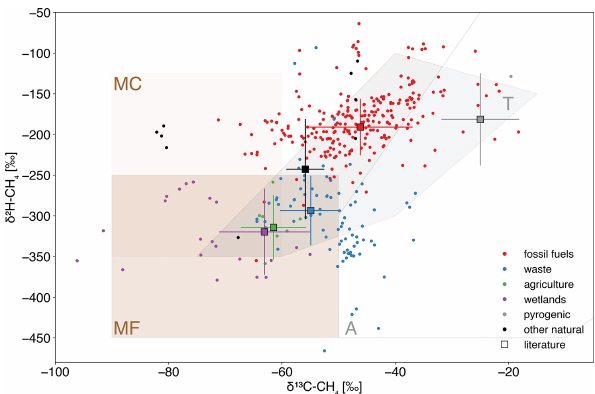
Figure 2. Dual isotope plot presenting measurement results from the EMID (circles); the literature data for the same source cate- gories, taken from Sherwood et al. (2017, 2021), and completed with the mean and standard deviation values from additional publi- cations (squares with error bars); shaded areas represent the differ- ent methanogenesis pathways from Milkov and Etiope (2018): MF: microbial fermentation, MC: microbial CO 2 reduction, T: thermo- genic, A: